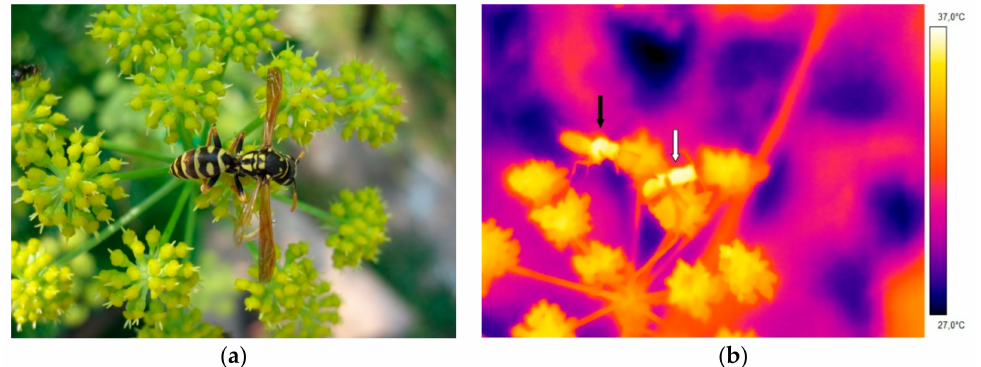
Figure 1. ( a ) Dead wasp ( Polistes dominula ) attached to an inflorescence of lovage for measuring the operative temperature (T e ). ( b ) Thermogram of a living wasp (left, black arrow) foraging on lovage and a dead wasp (right, white arrow), measured at an ambient temperature of 30 ◦